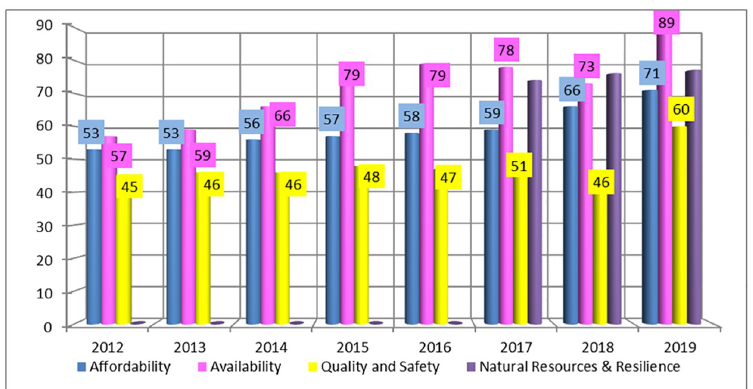
Fig 2. Dynamics of the categories of the indicator of the Global Food Security Index of Ukraine. Source: based on [63, 73–80].